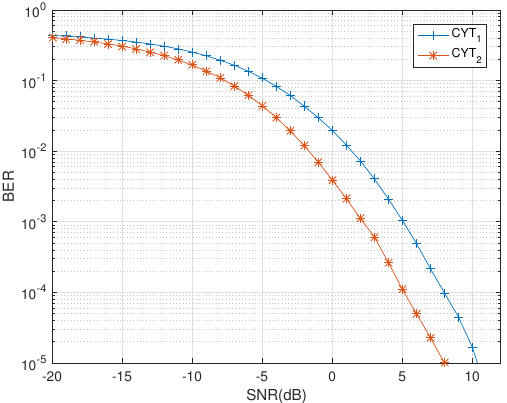
Figure 3. BER vs. SNR performance of QODs CYT 1 and CYT 2 .